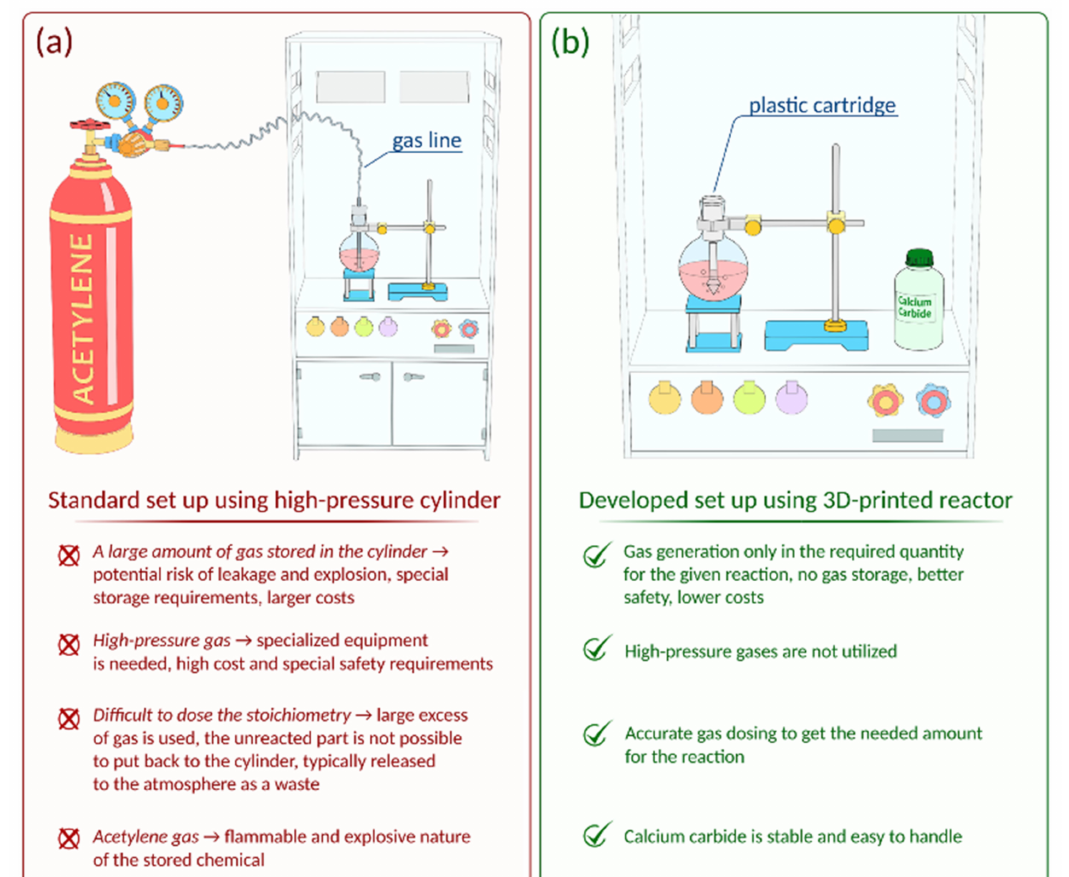
Figure 1. ( a ) Usage of a high-pressure acetylene cylinder (a standard approach); ( b ) application of a 3D printed on-demand acetylene generator (i.e., acetylene cartridge) without gas storage (cylinder-free approach, used in this